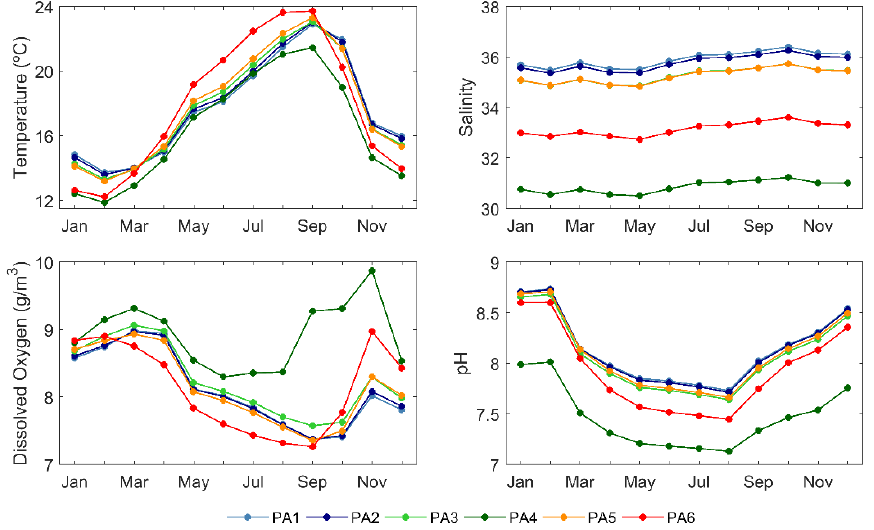
Figure 8. Monthly mean of water temperature (°C), salinity, DO (g/m 3 ), and pH at six points throughout the Ria de Alvor (red dots in Figure 1B).